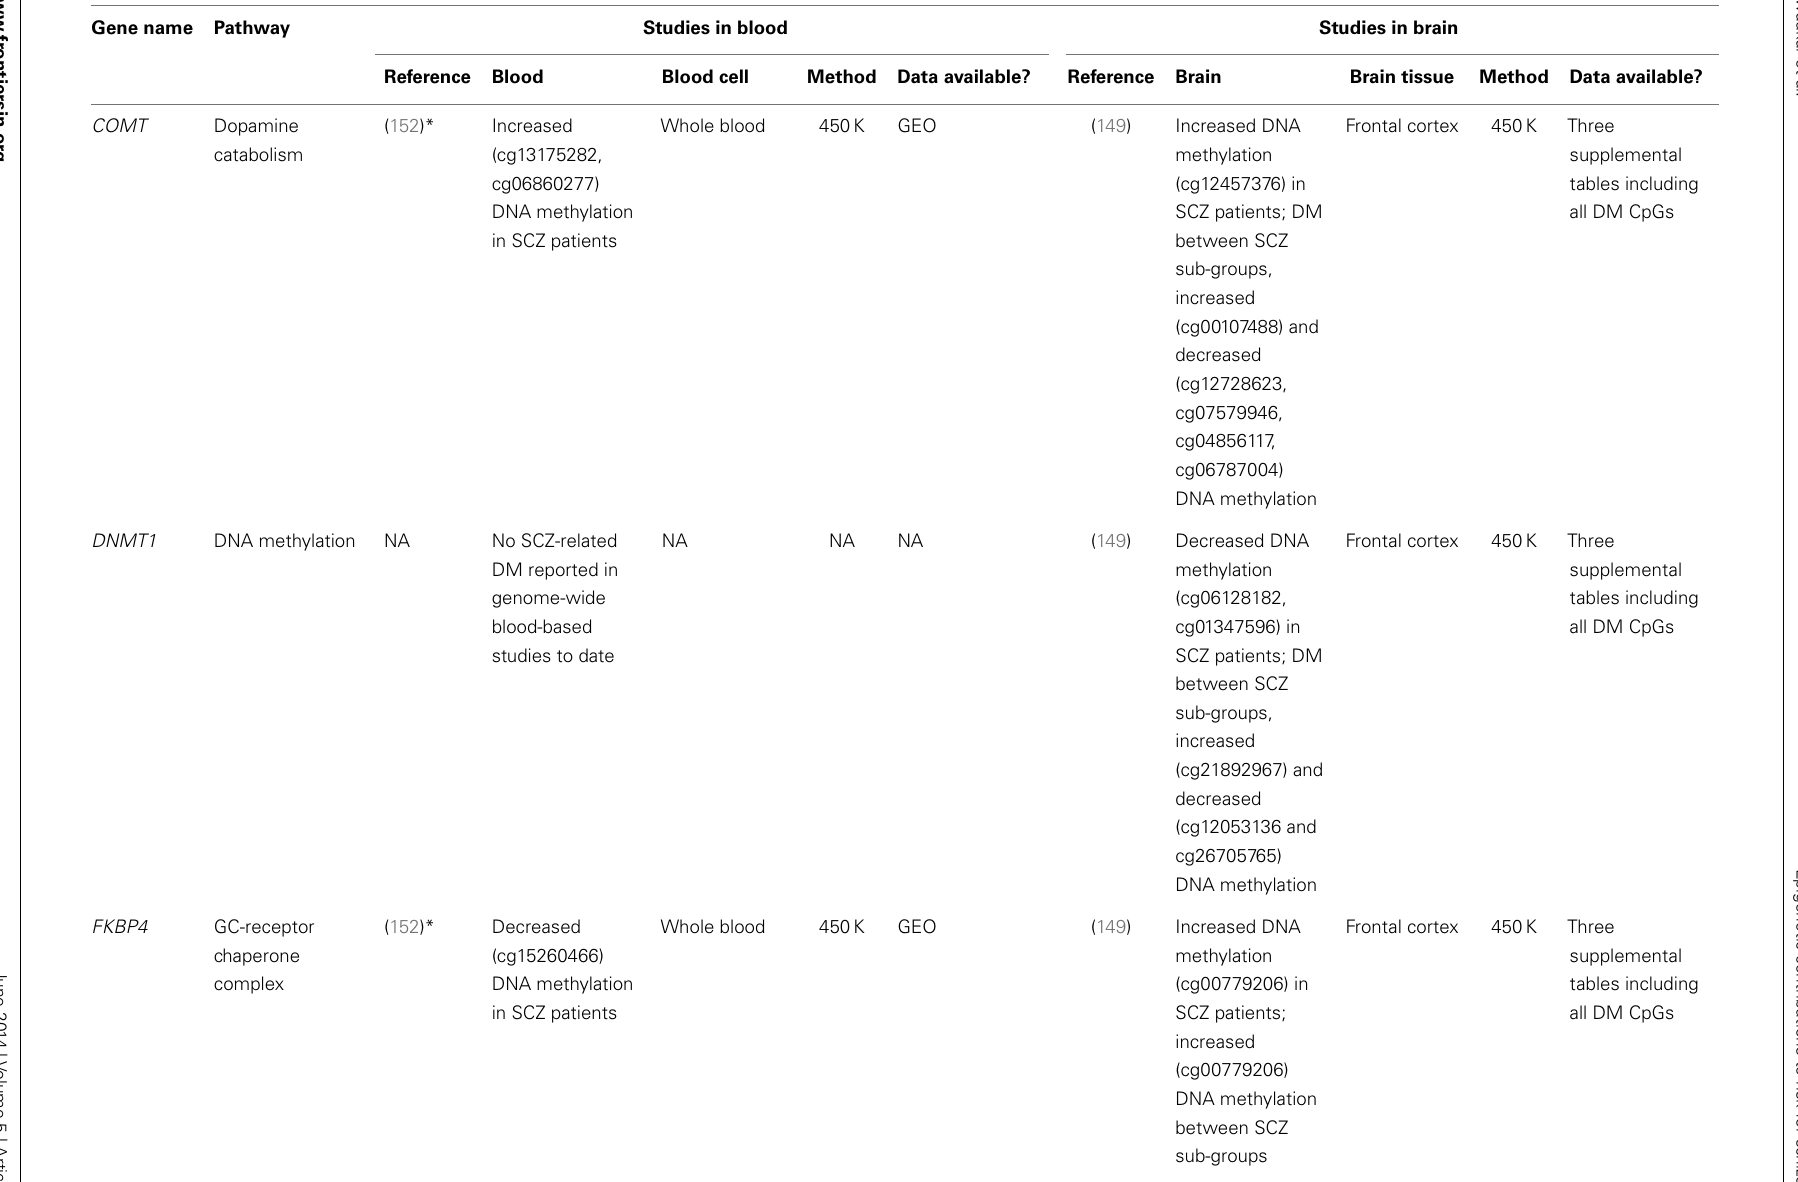
Table 1 | Summary of genome-wide studies reporting differential DNA methylation a (DM) within stress-sensitive genes in blood or brain